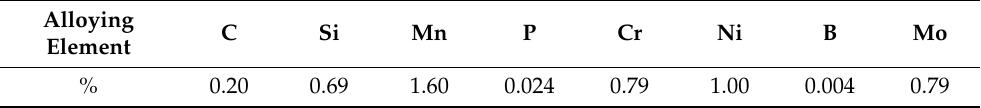
Table 1. Chemical composition Hardox 400